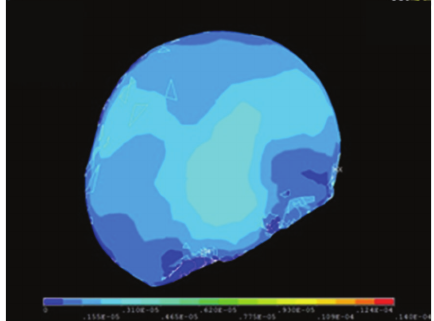
Figure 23: Strain graph when the ICP is 5.0 kPa.